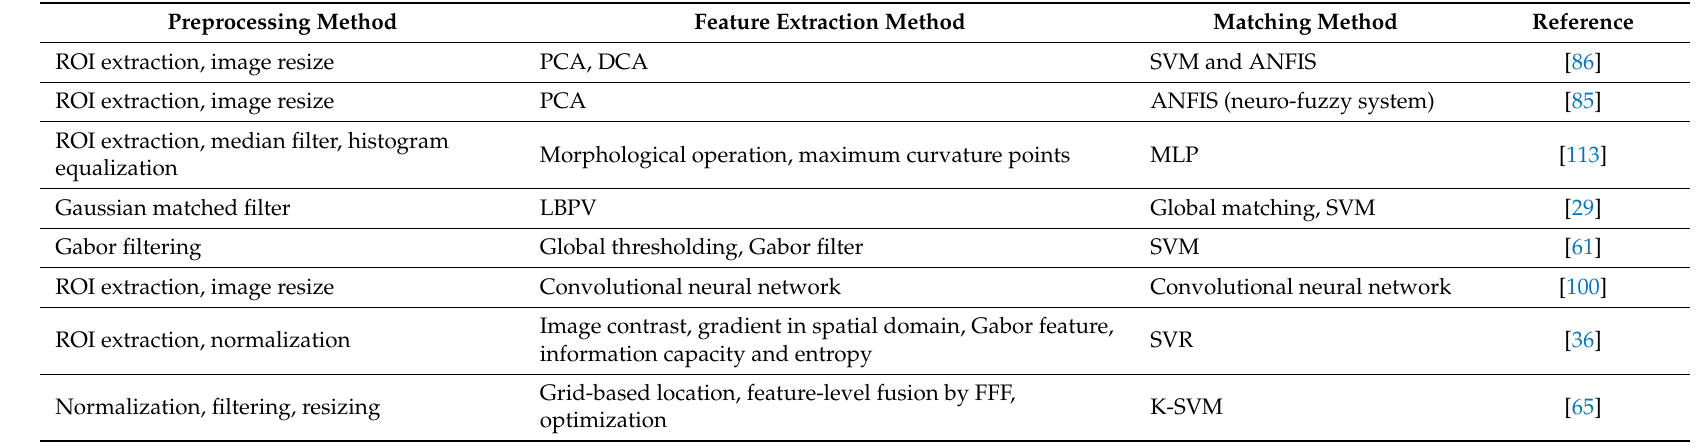
Table 4. Traditional Machine learning approaches for finger vein